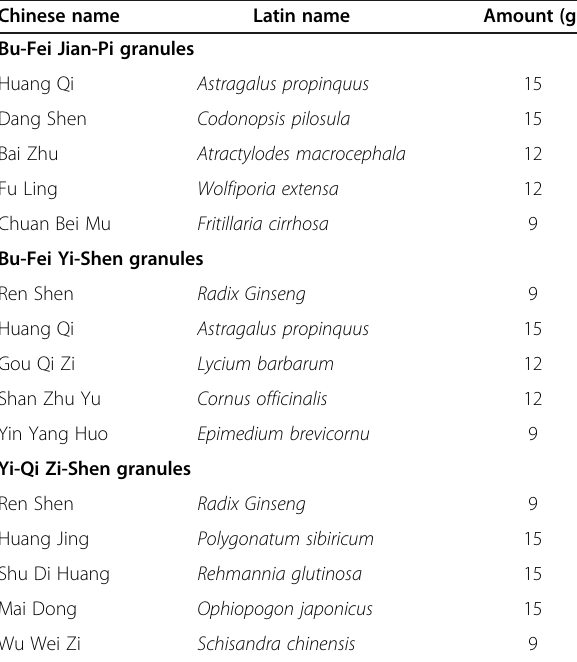
Table 2 Main components of traditional Chinese medicine